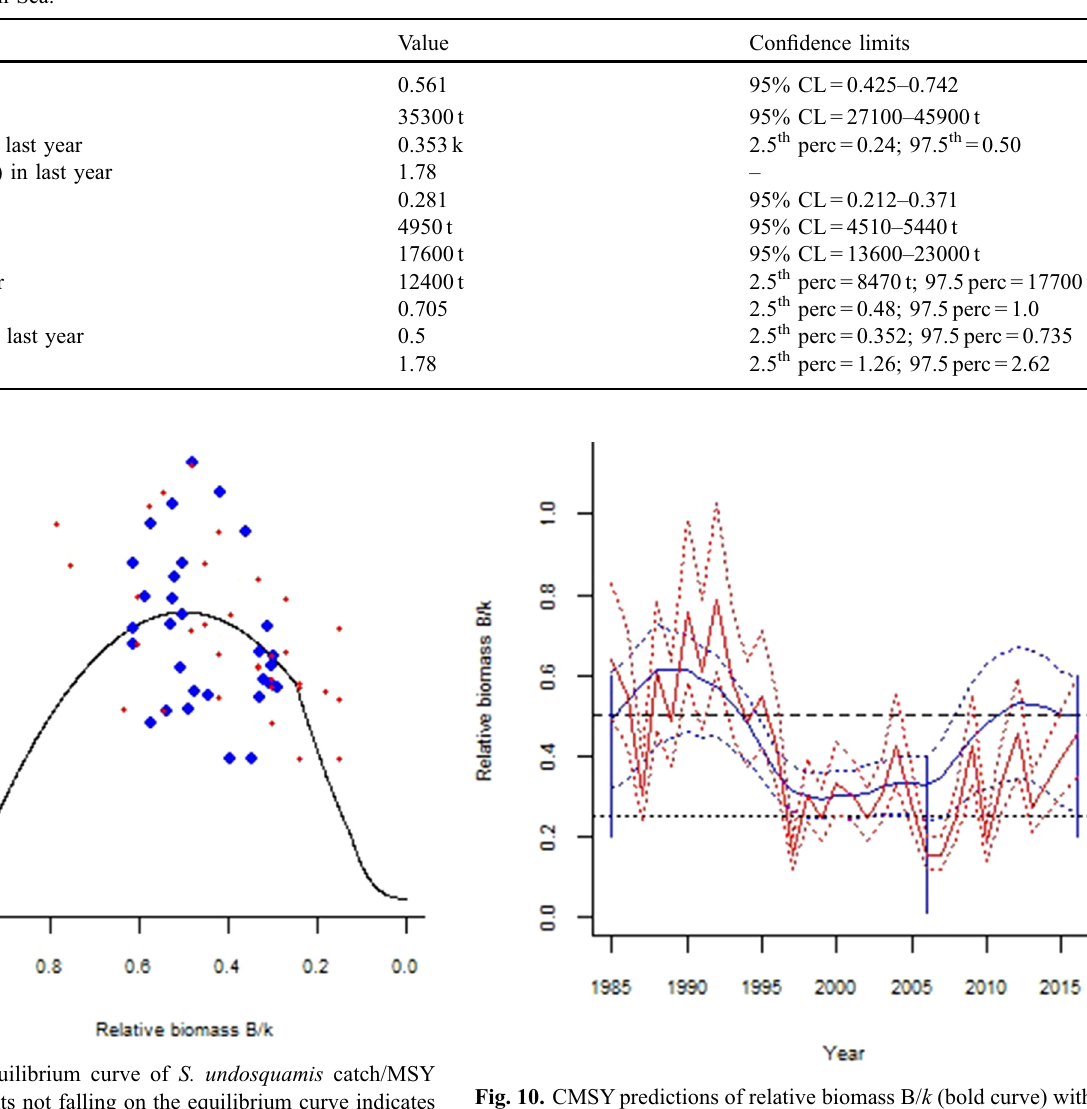
Table 1. Fisheries reference points based on Bayesian Schaefer model (BSM) analysis for the management of S. undsquamis stock in southeastern Arabian Sea.